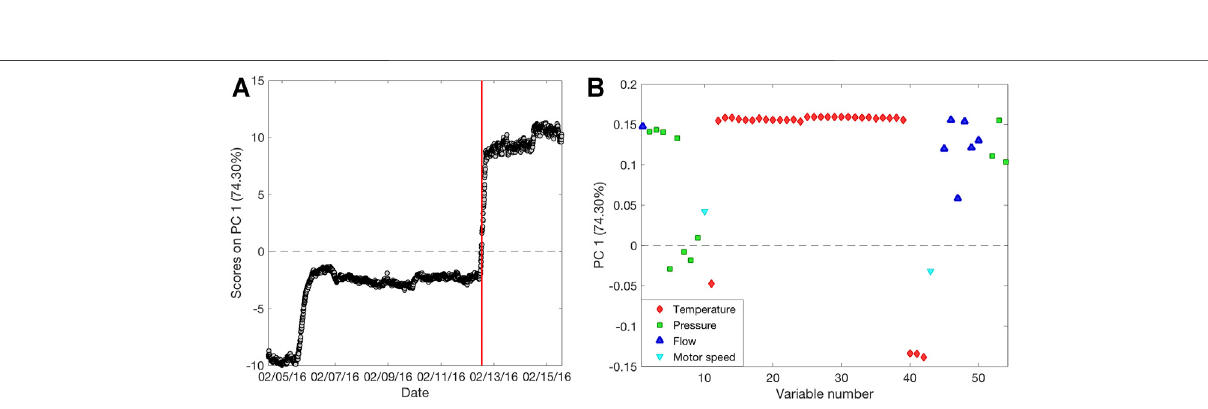
Frontiers in Chemistry |